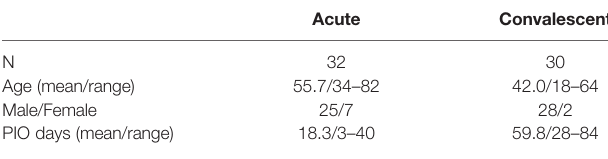
TABLE 1 | Characterization of COVID-19 patients.